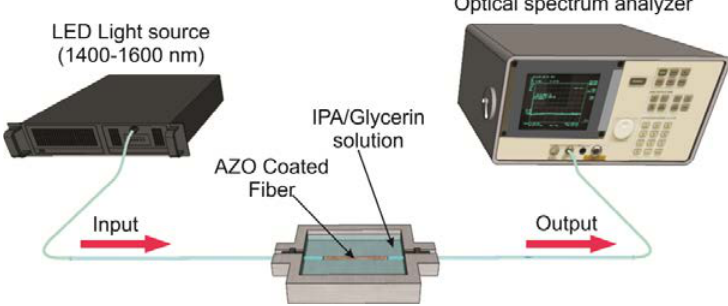
Figure 4. Experimental setup of the refractive index sensing optical fiber system. IPA, isopropyl alcohol.